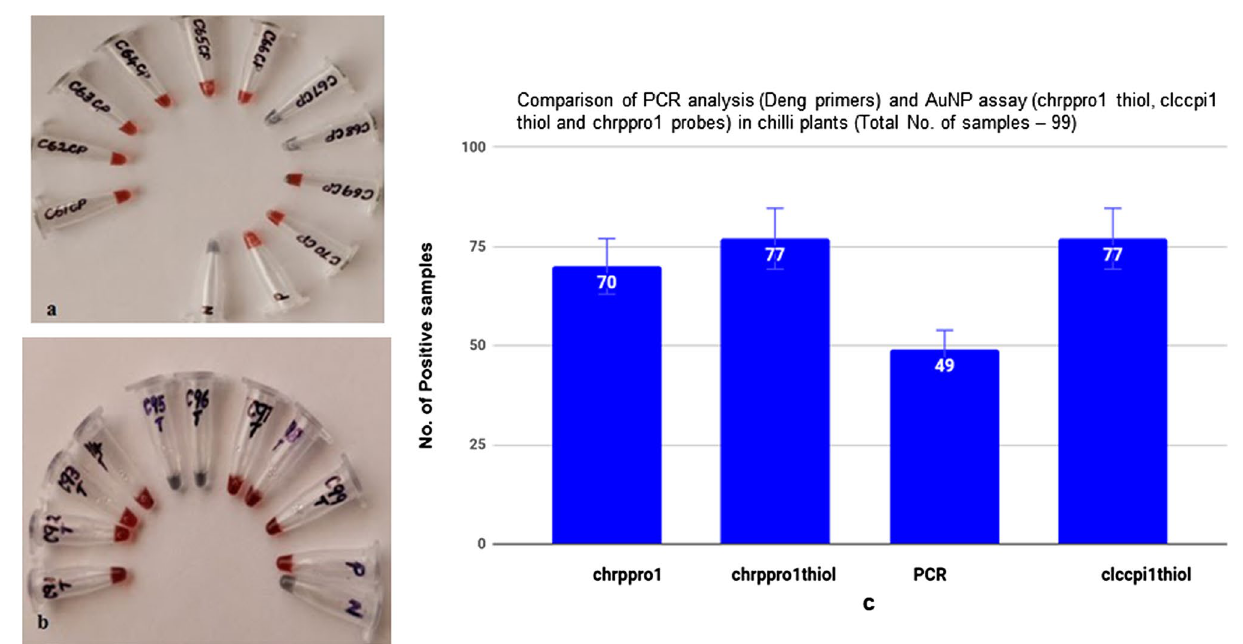
Figure 7. Detection of begomovirus in chilli samples using functionalized AuNPs. ( a ) With clccpi1 thiol probe; plant DNA (C71 to C80); positive (P)—begomovirus infected chilli DNA; N—healthy chilli DNA. ( b ) With chrppro1 thiol probe; plant DNA (C28 to C40); positive (P)—begomovirus infected chilli DNA; N—healthy chilli DNA. ( c ) Comparison of PCR and AuNP assay with different probes for chilli